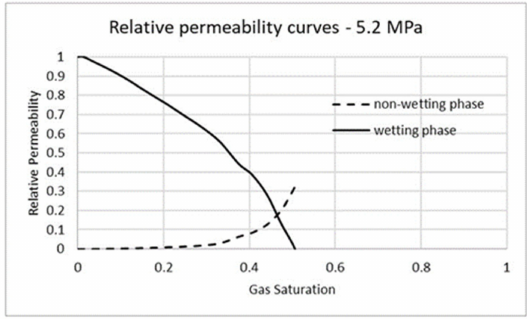
Figure 11. Relative permeability curves at inlet pressure of 5.2 MPa.